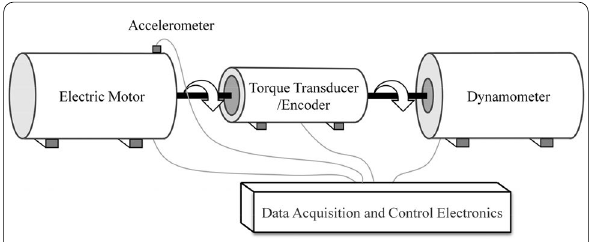
Table 1 Description of the experimental rolling bearing